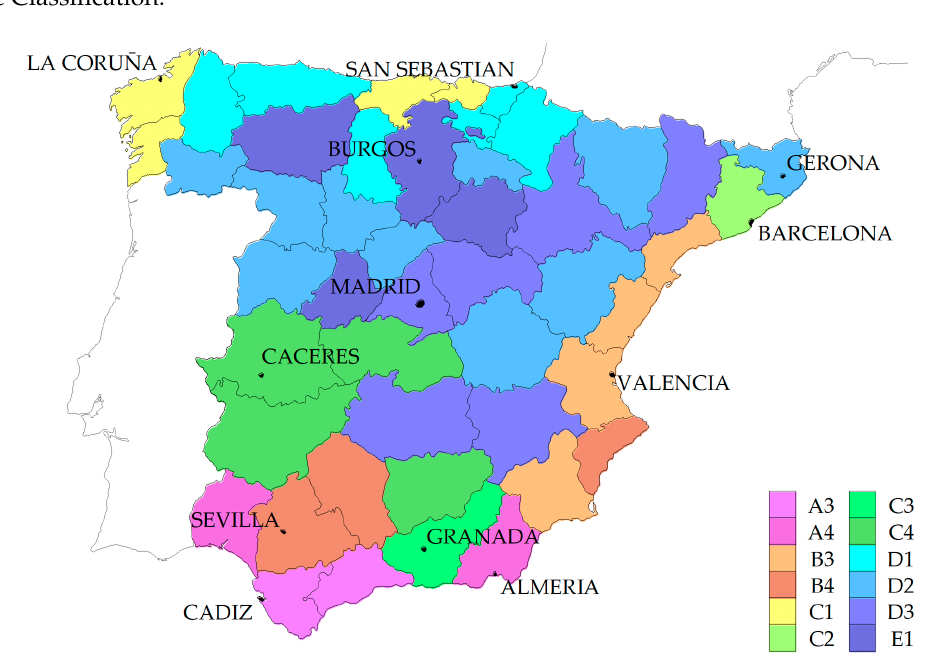
Figure 1. Distribution of climate zones in Spain.